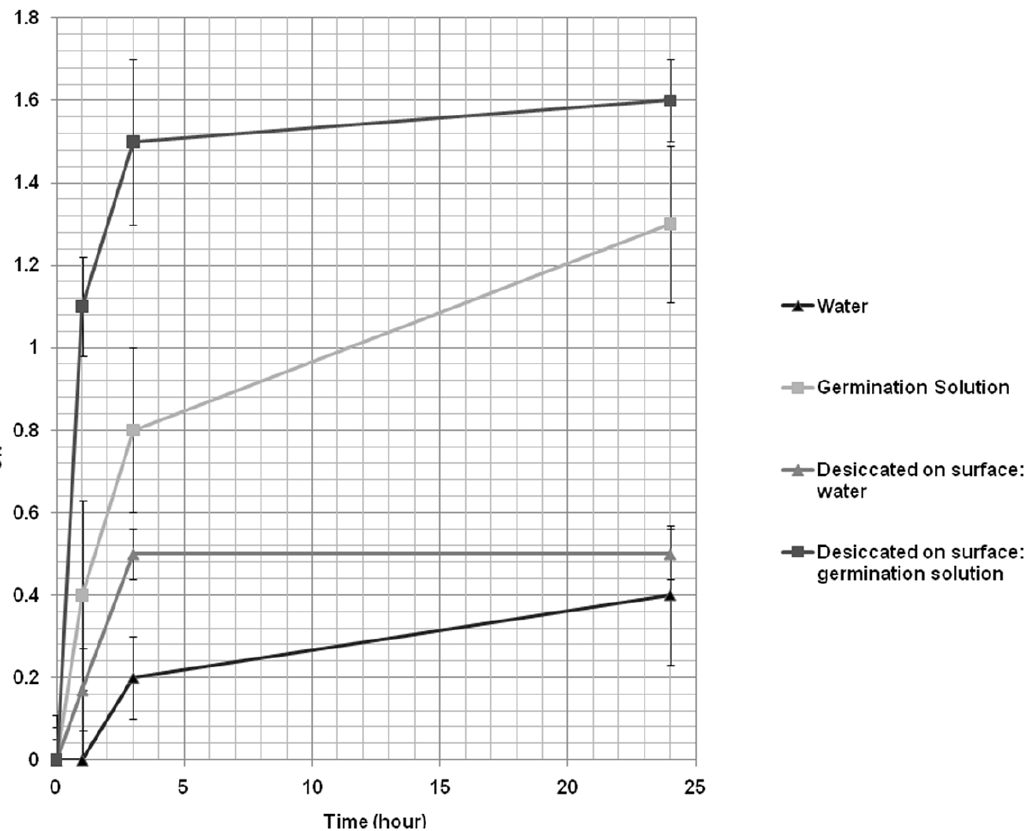
Figure 4. Survival of dormant and germinating C.difficile spores on surfaces in room air. Spores of the four experimental strains were incubated in sterile deionized water or germination solution under ambient conditions. Spore either remained in solution or were allowed to desiccate on surfaces over a 24 hour period. Mean reduction in recovery of viable dormant and germinating spores exposed to room air on surfaces (desiccated) was compared with baseline levels of spores inoculated onto surfaces. Mean reduction of viable spores in solution was assessed by enumerating serially diluted plate cultures at each time point in comparison with baseline levels of spores.